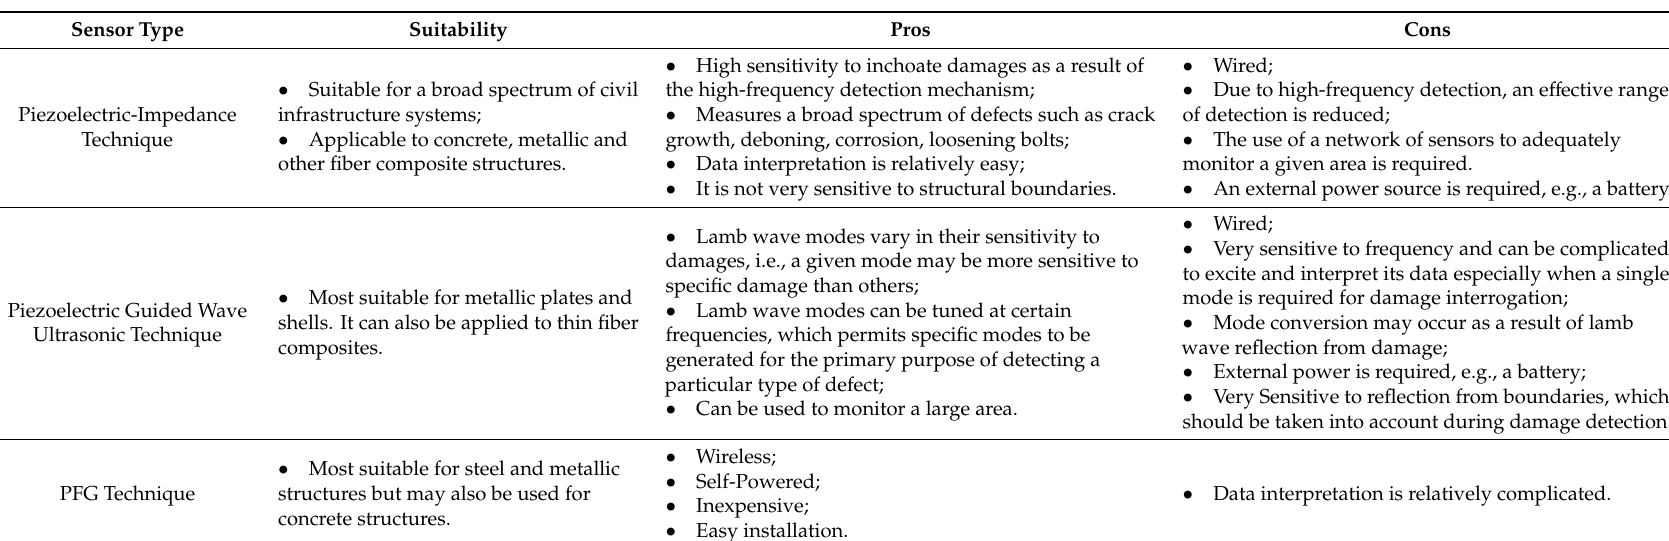
Table 2. Pros and cons of the piezoelectric electromechanical impedance, ultrasonic Lamb wave and PFG methods for SHM